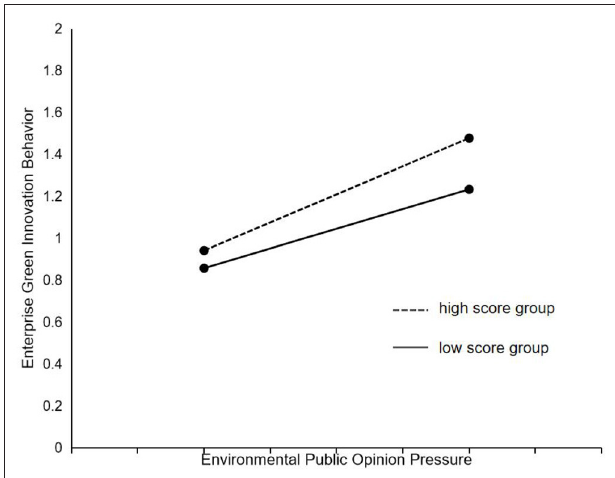
FIGURE 3 | The moderating effect of incentive environmental regulation.